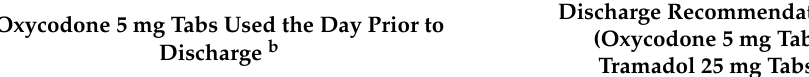
Table A1. VAPHS Opioid Prescribing Inpatient